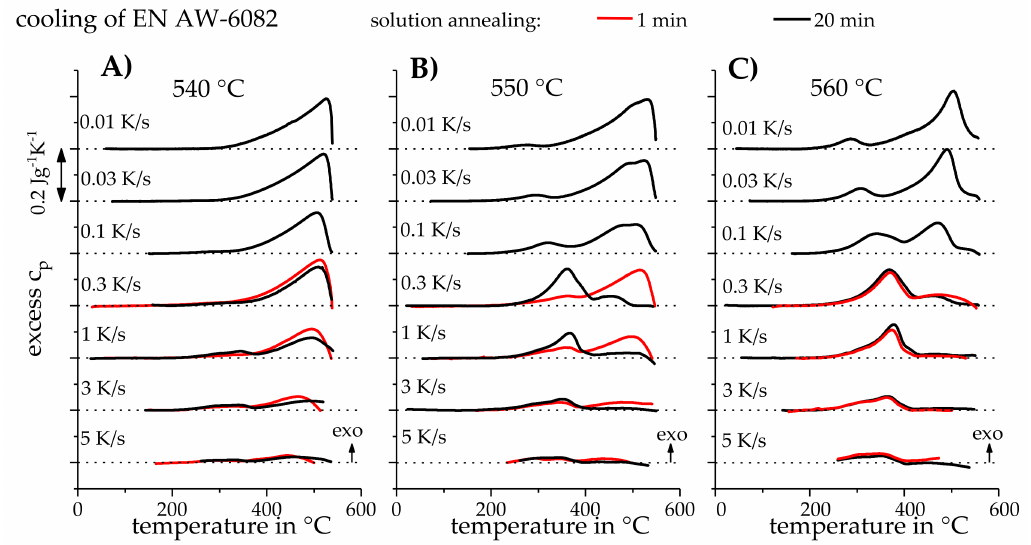
Figure 3. DSC cooling curves of EN AW-6082 (initially T651) with cooling rates from 0.01 up to 5 K/s after solution-annealing at ( A ) 540 ◦ C, ( B ) 550 ◦ C and ( C ) 560 ◦ C for 1 min (red) and 20 min (black).